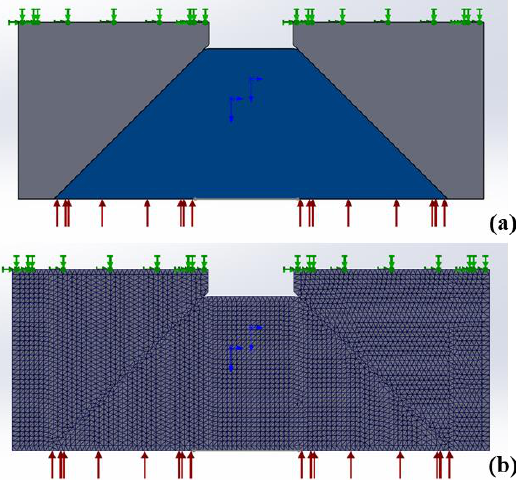
Figure 10. Boundary constraint and mesh division of finite element model. ( a ): boundary constraint image; ( b ): mesh division image.